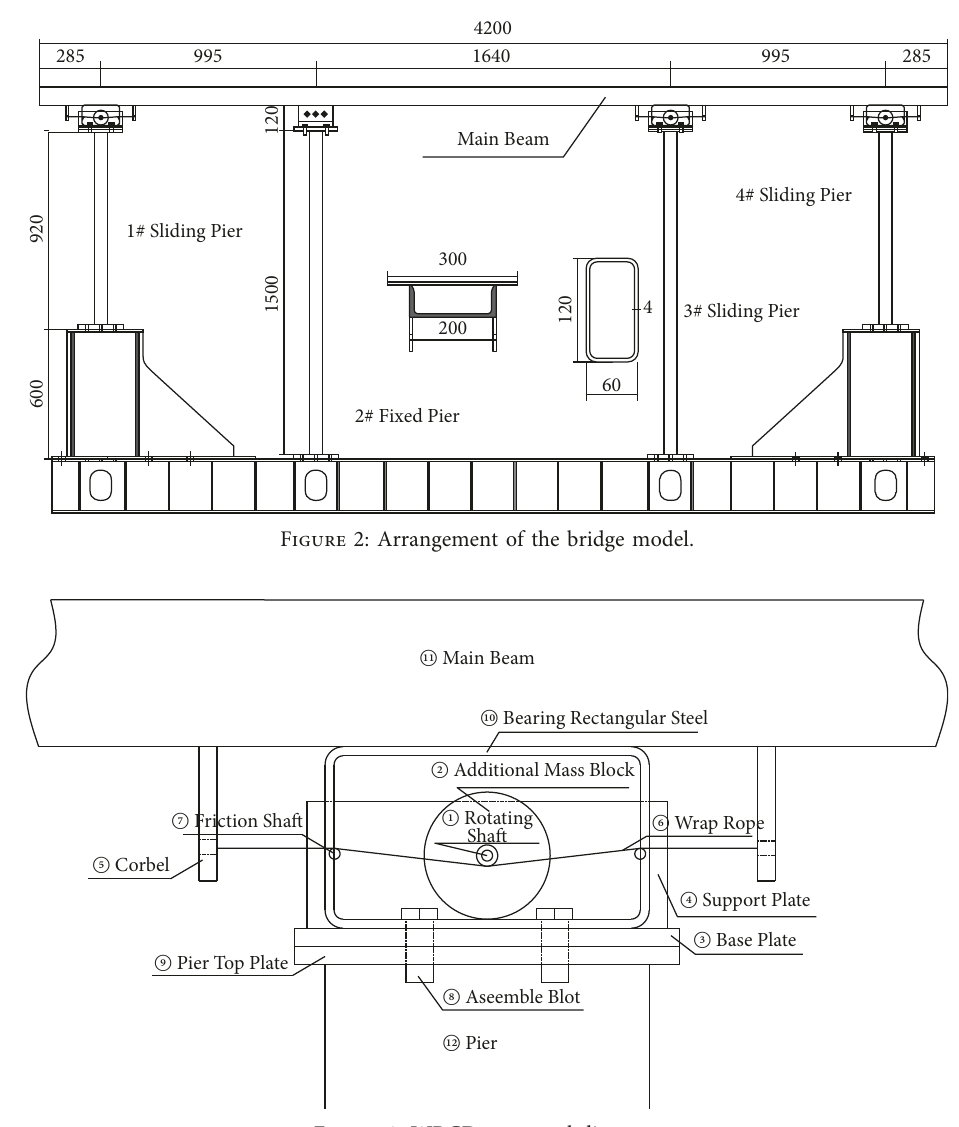
Figure 3: WRCD structural